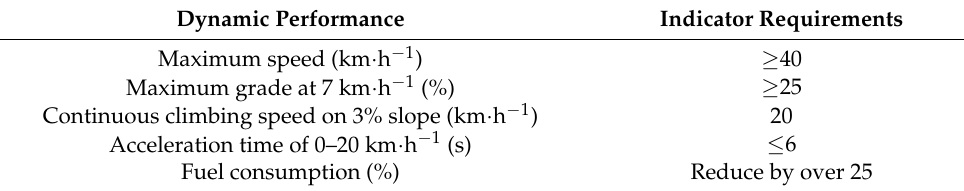
Table 1. Performance requirements of HETRTV.